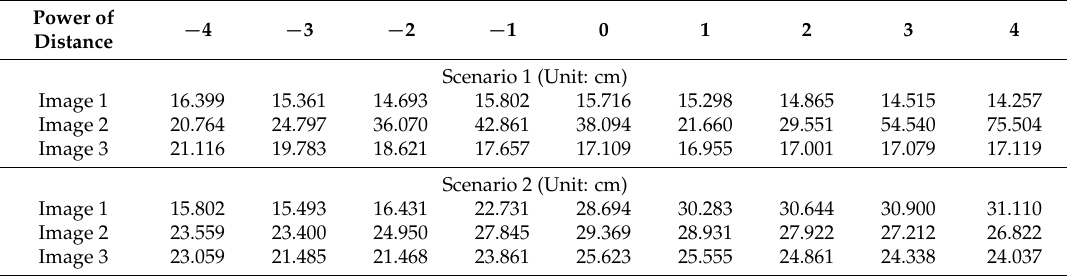
Table 7. The position error of analysis of adaptive weight for the HTC